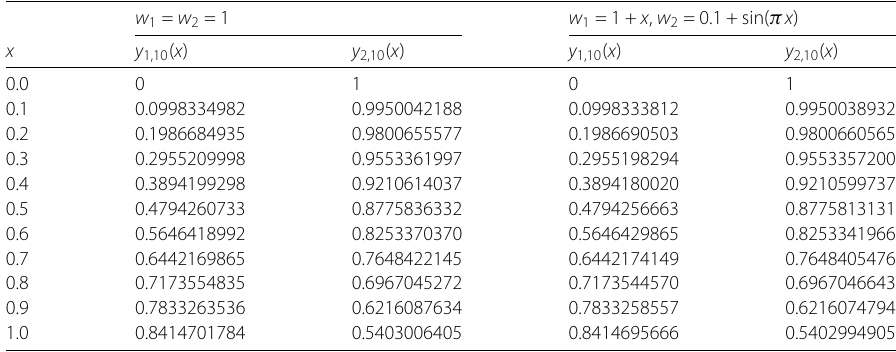
Table 2 Approximate solutions with n = 10 using the presented method for Example 1